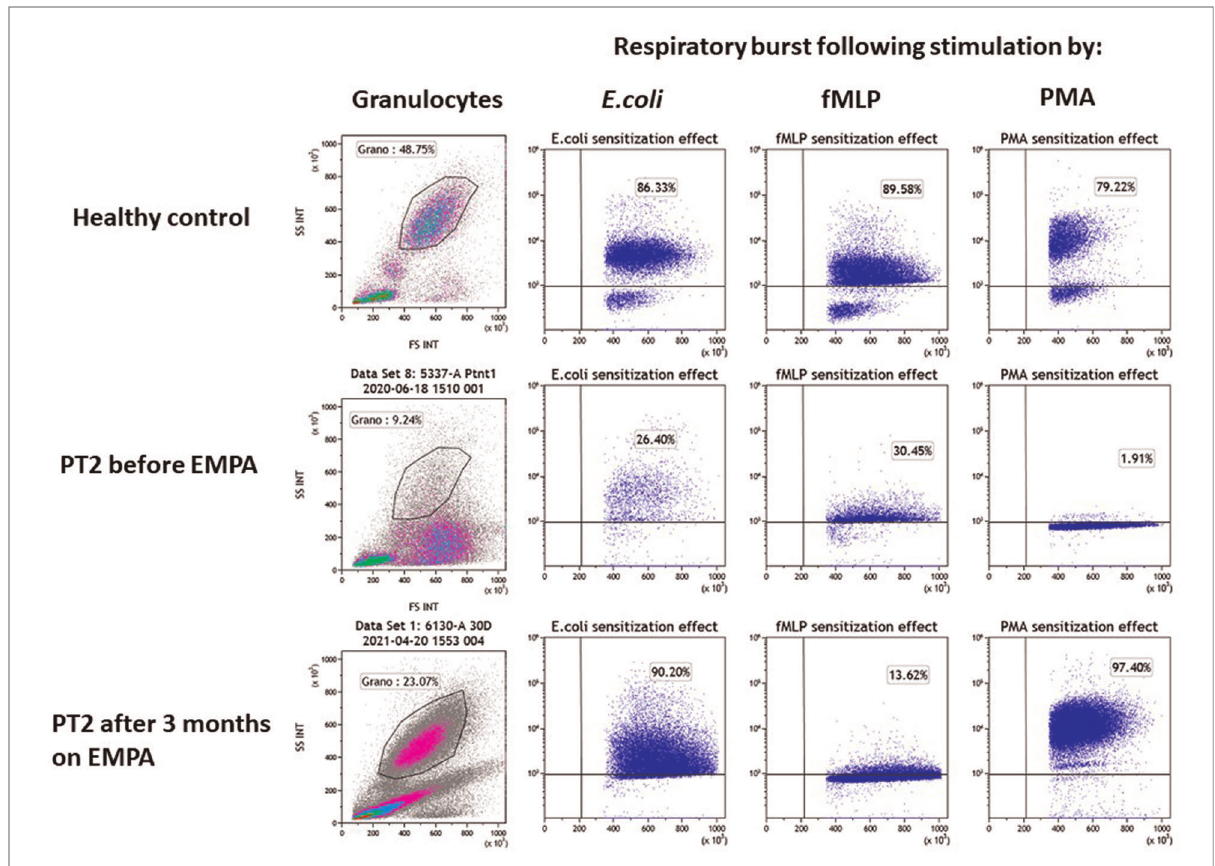
FIGURE 4 Evaluation of the impact of empagli fl ozin treatment on neutrophil function. Neutrophil function was evaluated for PT2 by measuring the respiratory burst capacity of granulocytes before and after EMPA treatment. Granulocyte abundance is shown on the left column as the percentage of leukocytes measured by fl ow cytometry. The impact of E.coli , fMLP and PMA (second, third and fourth columns from left) is shown on the stimulation of the respiratory burst in blood samples from a healthy control (top row) and PT2 before (middle row) and after 3 month on EMPA treatment (bottom row). The assay shows normalization of neutrophil ’ s function and number after 3 months of EMPA